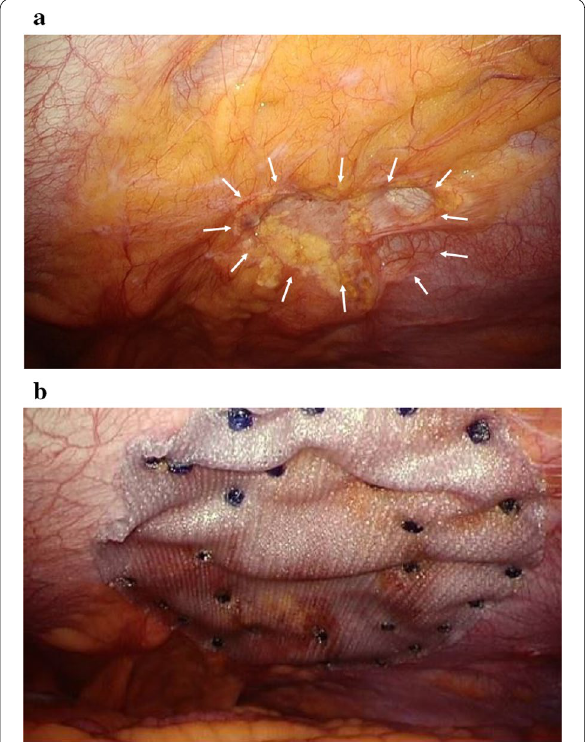
Fig. 6 Intraoperative photograph from the second (hernial repair) surgery. a Hernial orifice shows scarring (arrows). b Mesh is secured using the double-crown